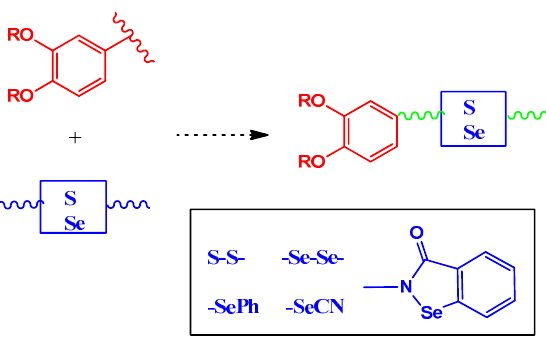
Figure 1. General structure of the chalcogen-polyphenol conjugates prepared herein.